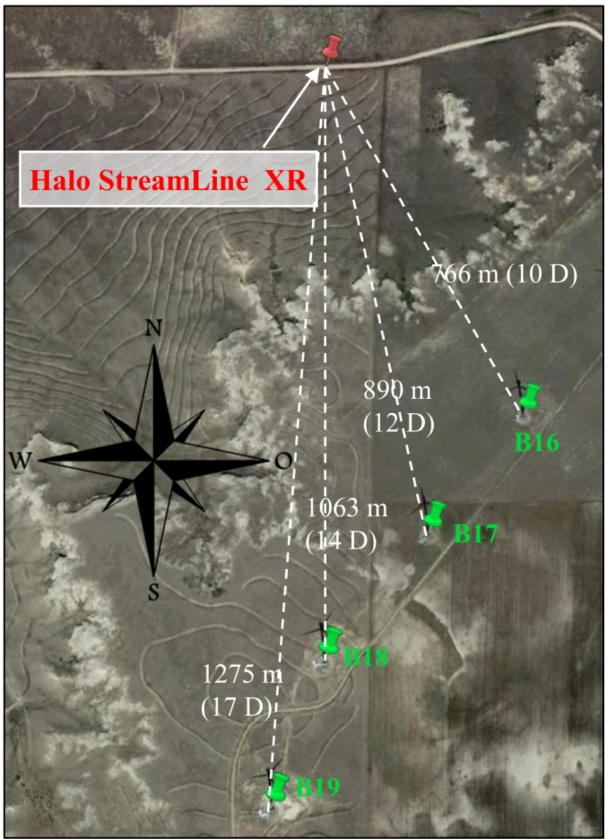
Figure 14. Satellite map of the site for the deployment of the Wind- Cube 200S lidar, including the four Mitsubishi wind turbines under investigation. Source: ©Google